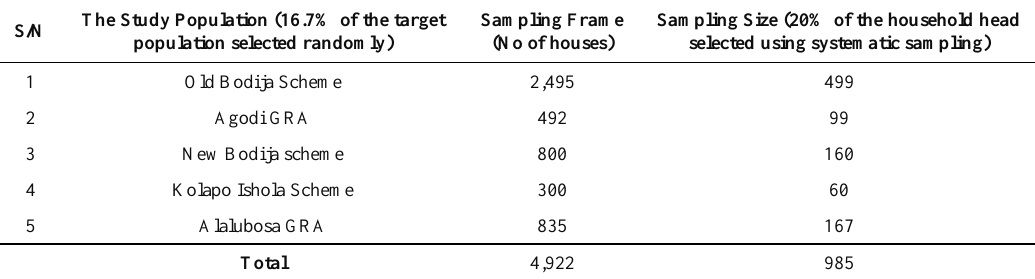
Table 1. Target Population for the Study